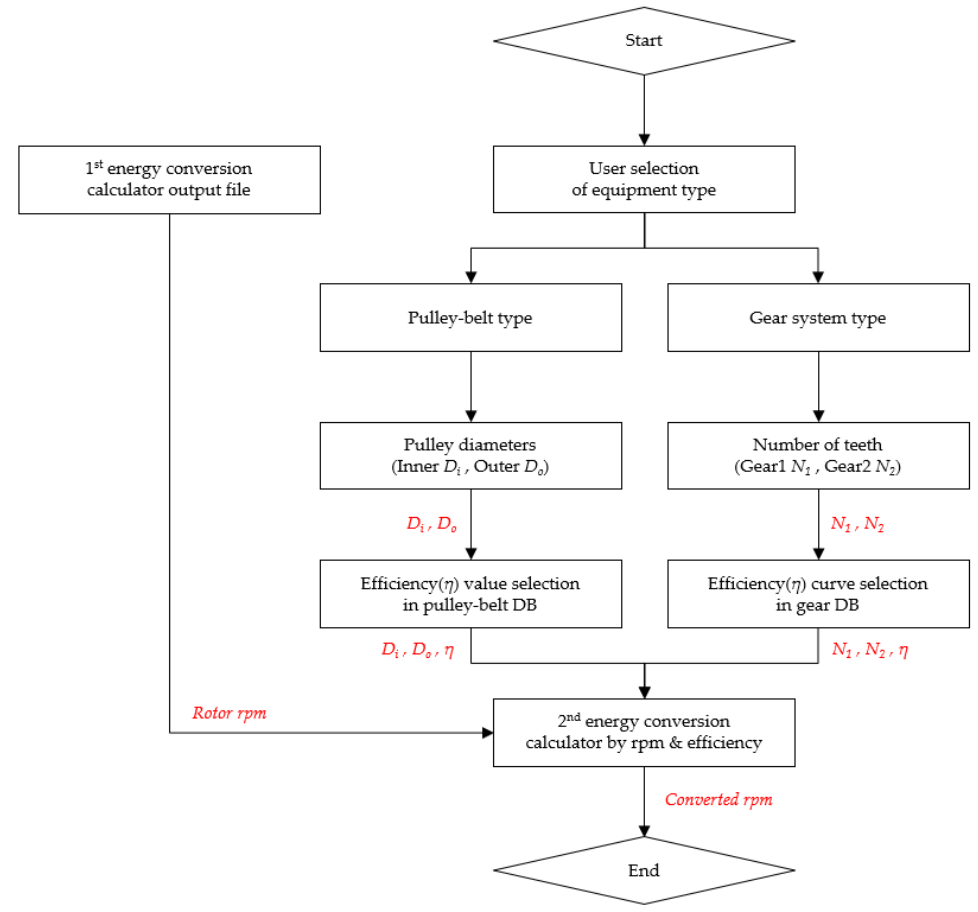
Figure 7. Reliability assessment algorithm of secondary energy conversion mechanical system.